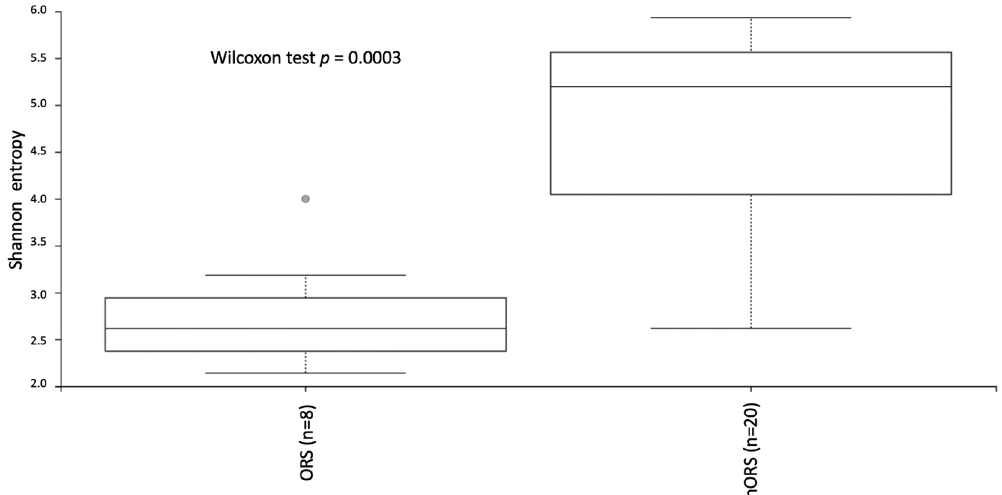
Figure 1. Shannon diversity (alpha diversity) between microbiomes collected from lesion sites in odontogenic and nonodontogenic rhinosinusitis samples, as revealed by 16SrRNA sequencing (Wilcoxon test p = 0.0003). ORS: odontogenic rhinosinusitis; nORS: nonodontogenic